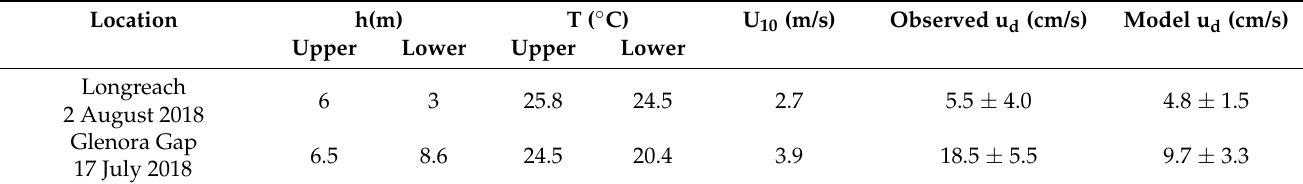
Table 1. Estimated and modelled layer parameters for 17 July and 2 August